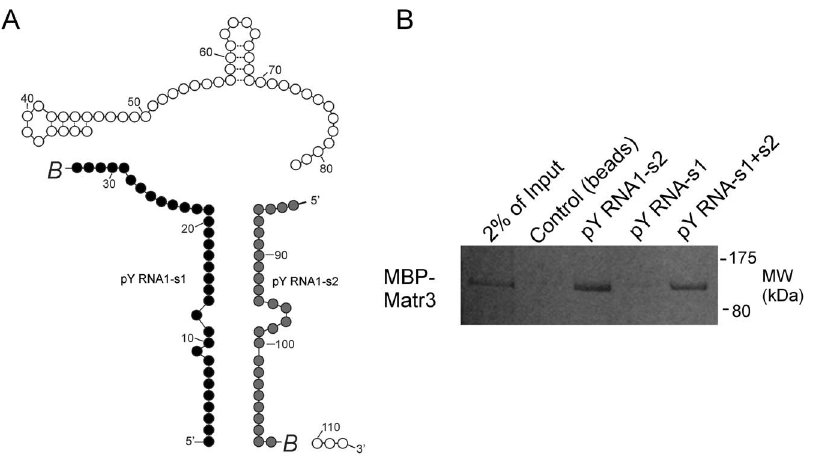
Figure 7. pY RNA1-s2 selectively binds to Matr3. A. Schematic depicting the two regions of Y RNA used in a binding assay with a Maltose Binding Protein fusion with Matr3 (MBP-Matr3). Biotin groups, indicated with italic B , were chemically attached to the 3 9 end of each oligo. pY RNA1- s1 is indicated with black circles and pY RNA1-s2 with grey circles. B. the RNA oligonucleotides pY RNA1-s1, pY RNA1-s2 or an equimolar mix of both oligos (pY RNA1-s1 + s2) were coupled to streptavidin beads, incubated with MBP-Matr3 and then washed extensively. A lysate prepared from six rat retinas was subsequently incubated with the beads, which were then washed; the proteins associated with the beads were recovered into sample buffer, resolved by SDS-PAGE and detected by Coomassie staining (details are available in the ‘‘Materials and